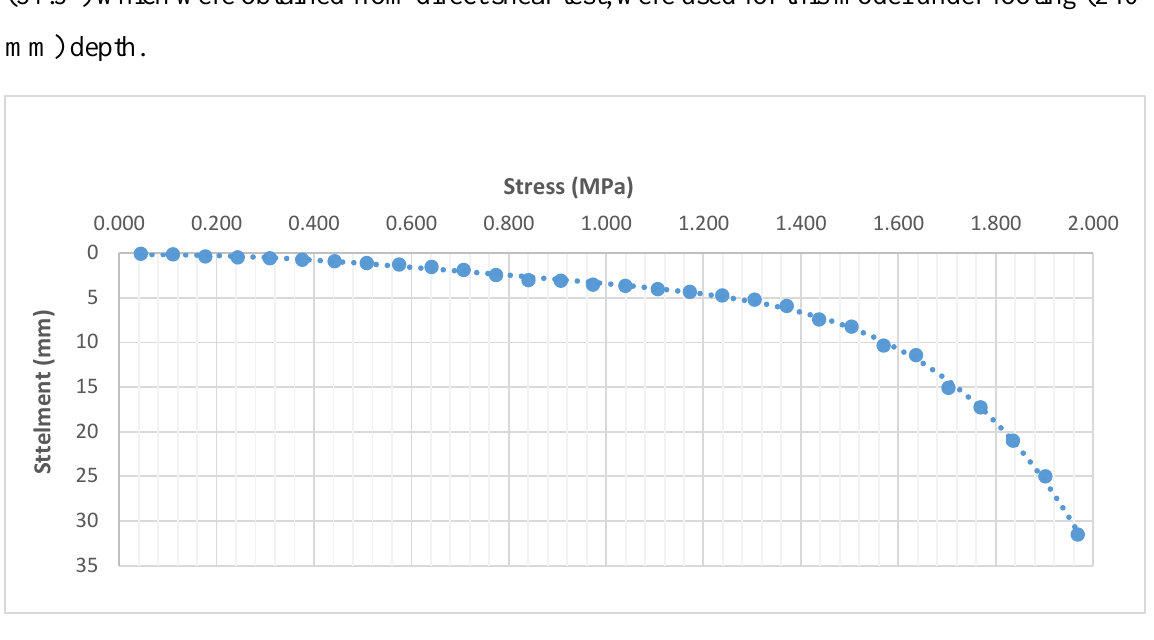
Fig. 13. Experimental model Relationship between normal stress versus vertical settlement for treated soil with (1.5 %) (PPF) and (6 %)